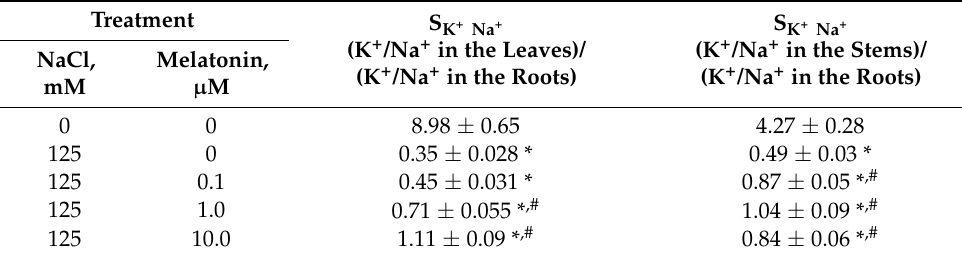
Table 3. Effect of melatonin on selective interorgan transport of ions by Solanum tuberosum plants under saline conditions.